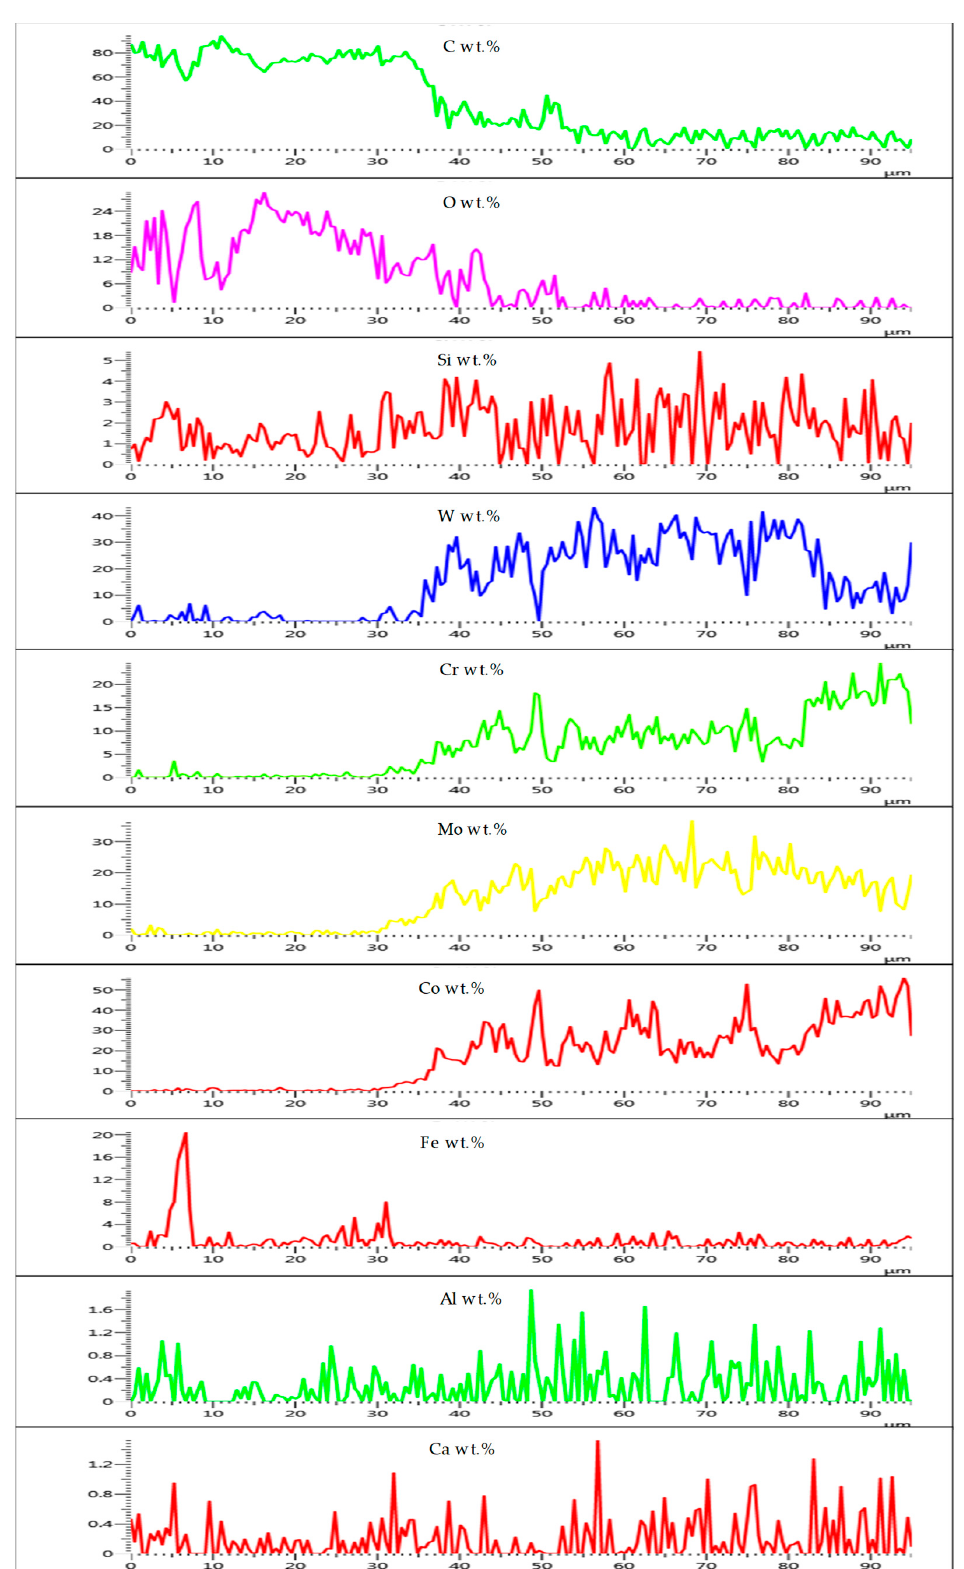
Figure A2. Exploded EDS analysis of T-800/WC oxide.